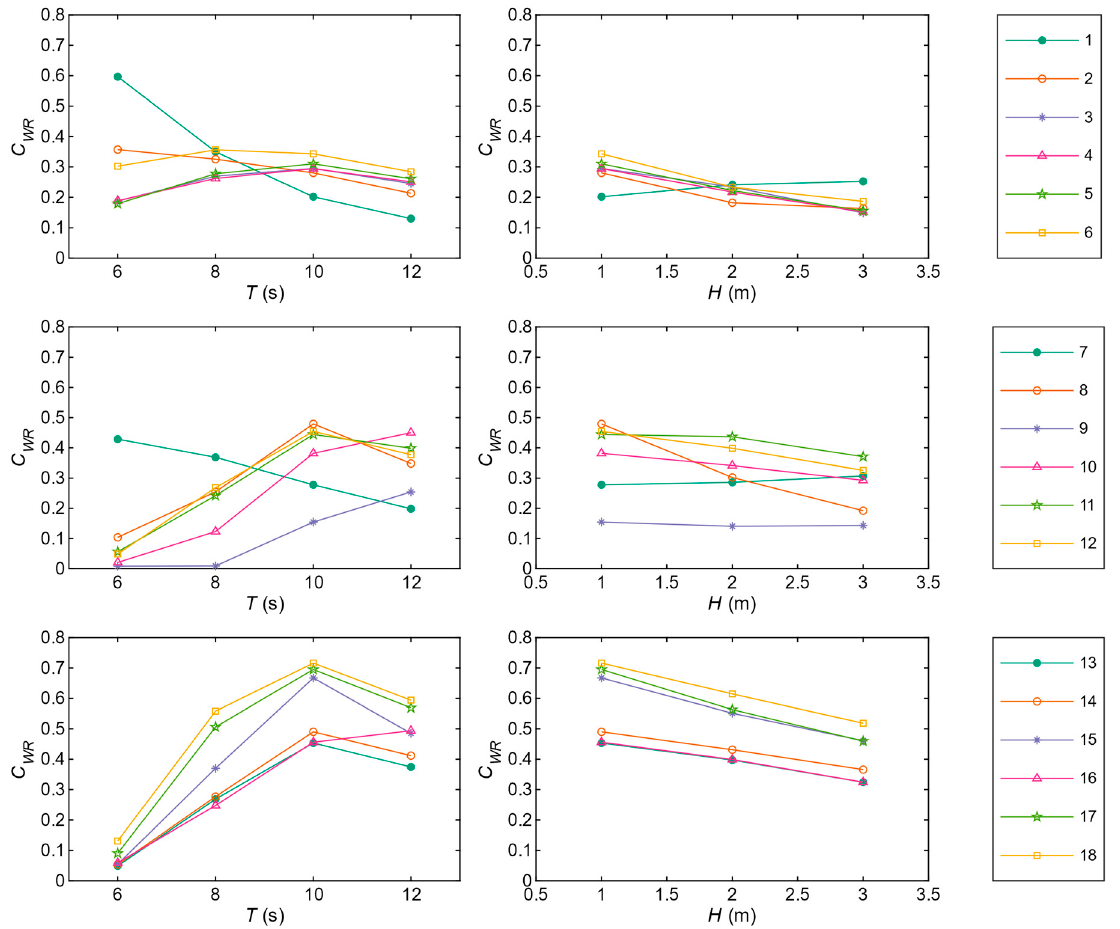
Figure 10. Values of the capture-width ratio ( C WR ) for the different OWC geometries tested. The U-shaped OWC designs (Models 2–6) present lower maximum values of the capture-width ratio ( C WR = 0.294–0.357) than the classic OWC design ( C WR = 0.597). However, these maximum values of the capture-width ratio are achieved (with the exception of Model 2) for periods closer to T = 10 s, so constituting a better design for being installed in the study area. In addition, the U-shaped designs present a smoother performance